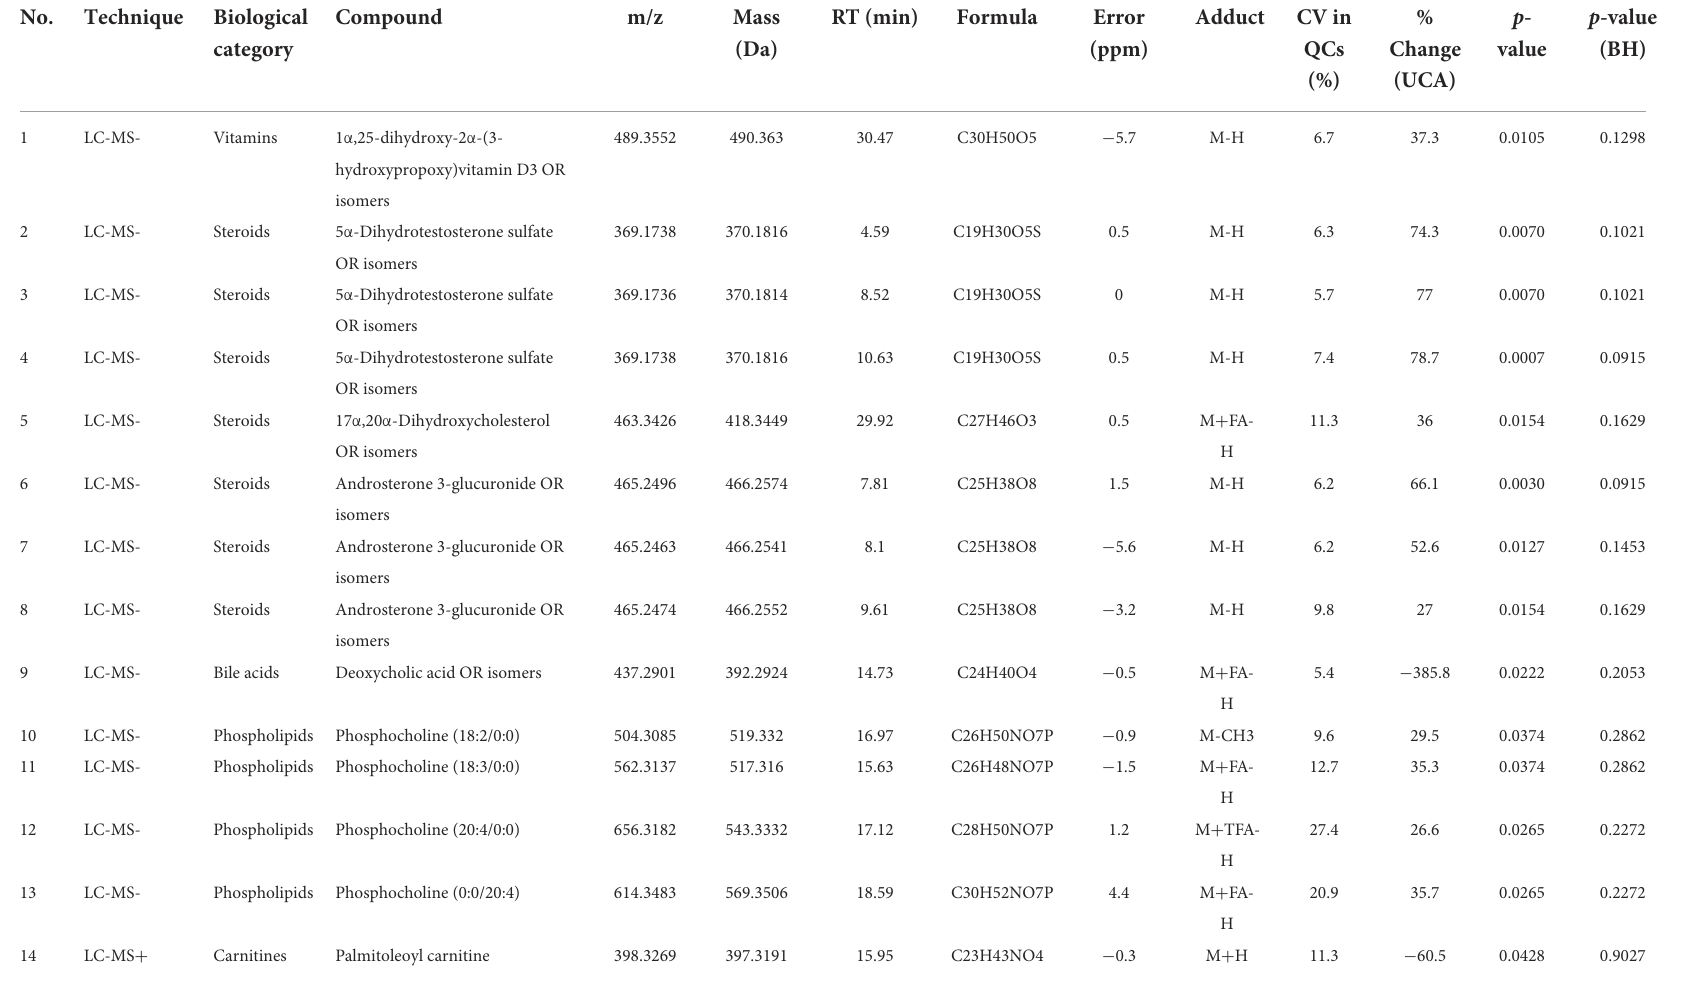
TABLE 2 Physicochemical characteristics of significant annotated signals in metabolomics through LC-MS/MS between UCNA and UCA